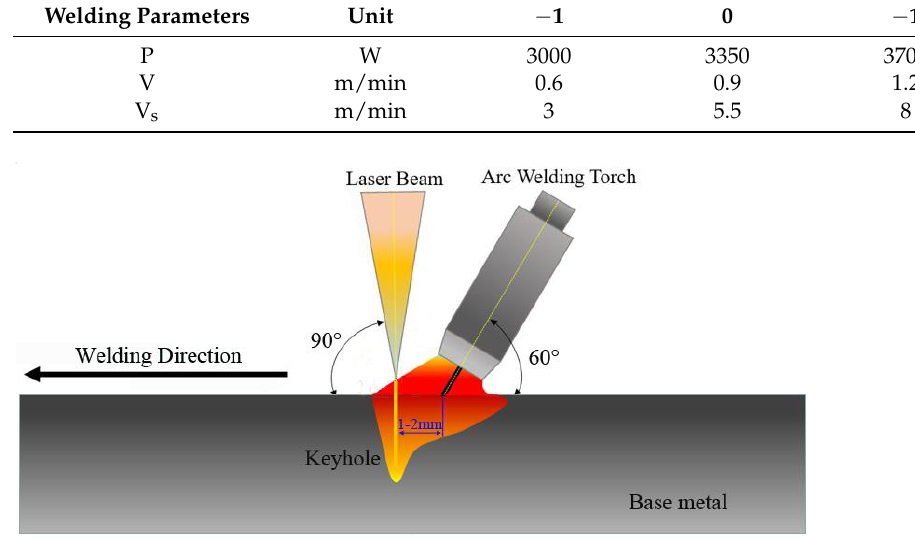
Figure 3. The schematic of laser-MIG hybrid welding system configurations.